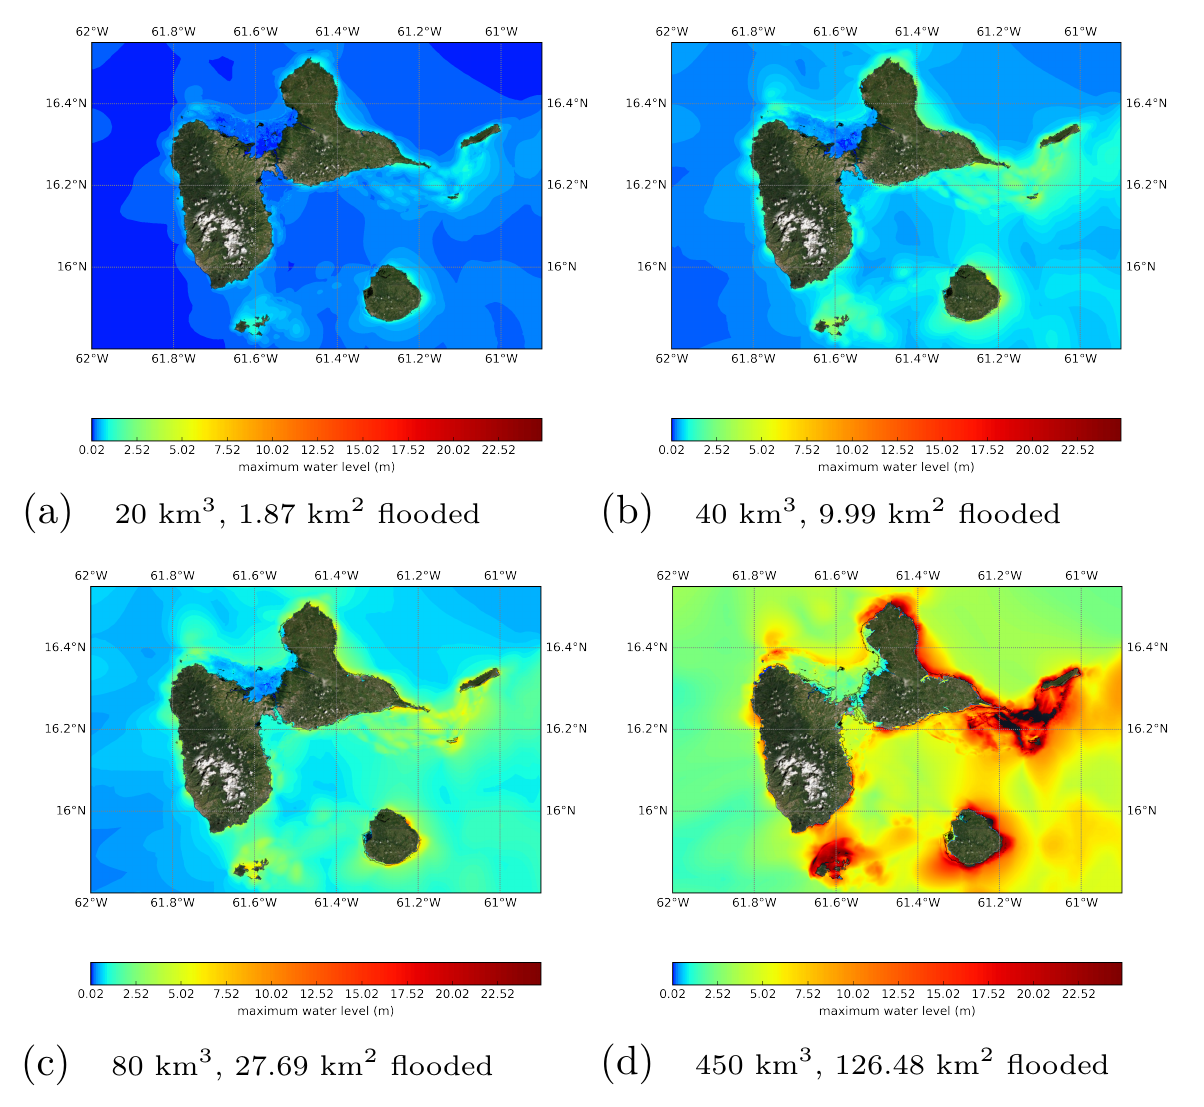
Figure 5. Maximum water level for each scenario for the present